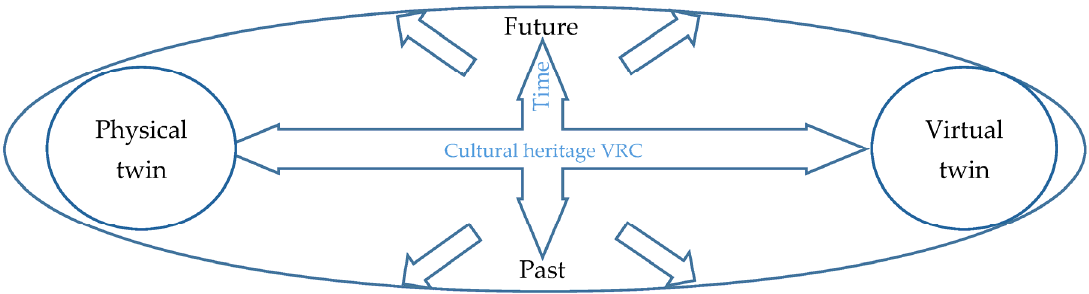
Figure 1. Cultural heritage metaverse.